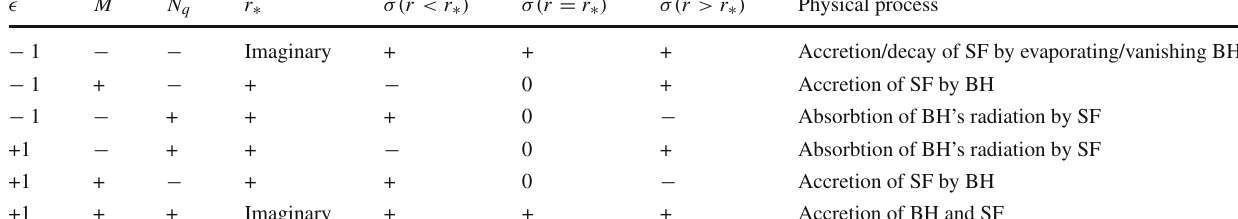
Table 5 BH and its surrounding quintessence field parameters for (cid:5) = ± 1. For the quintessence background, the positive energy condition may